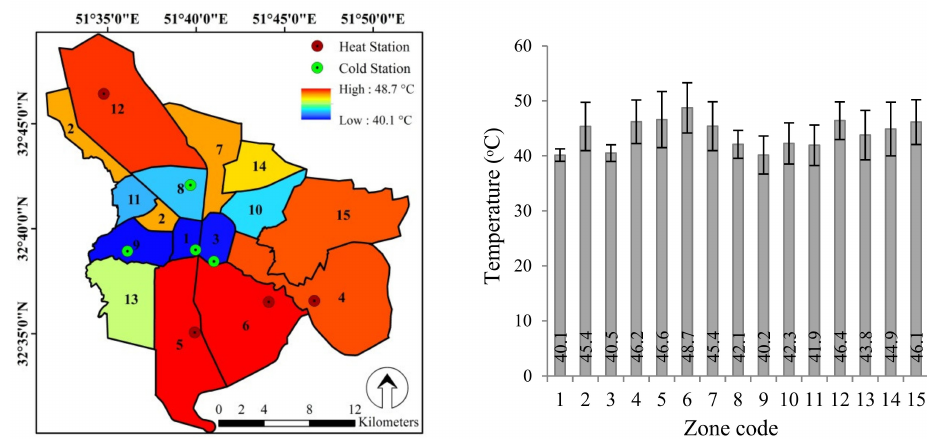
Figure 6. Map of the average LST in the management zones and location of selected heat and cold stations (left), and statistical summary chart (average and standard deviation: n = 9) of LST in the management zones